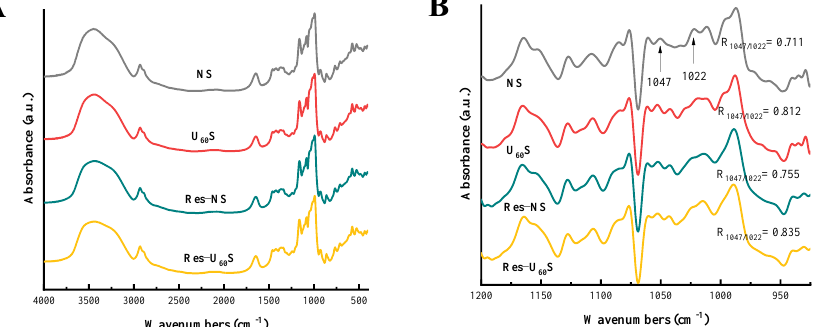
Figure 5. FTIR ( A ) and ATR-FTIR ( B ) spectra of different starch samples.